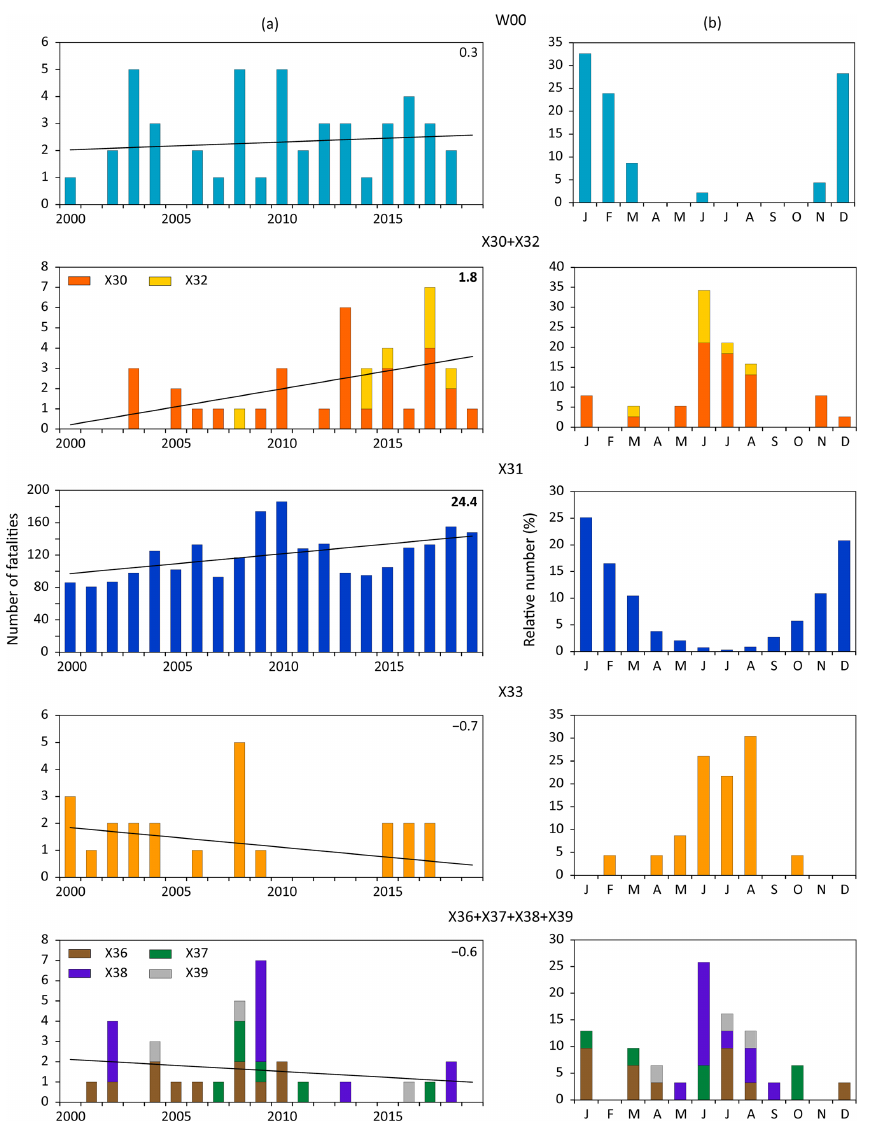
Figure 12. Fluctuations with linear trends (a) and annual variations (b) of fatalities associated with selected types of death in the 2000– 2019 period according to the Czech Statistical Office database: W00 – fall on ice or snow; X30 + X32 – excessive natural heat and solar radiation; X31 – excessive natural cold; X33 – lightning strike; X36 + X37 + X38 + X39 – avalanche, landslide or other earth movements, natural catastrophic storm, flood (inundation), and other and non-specified natural